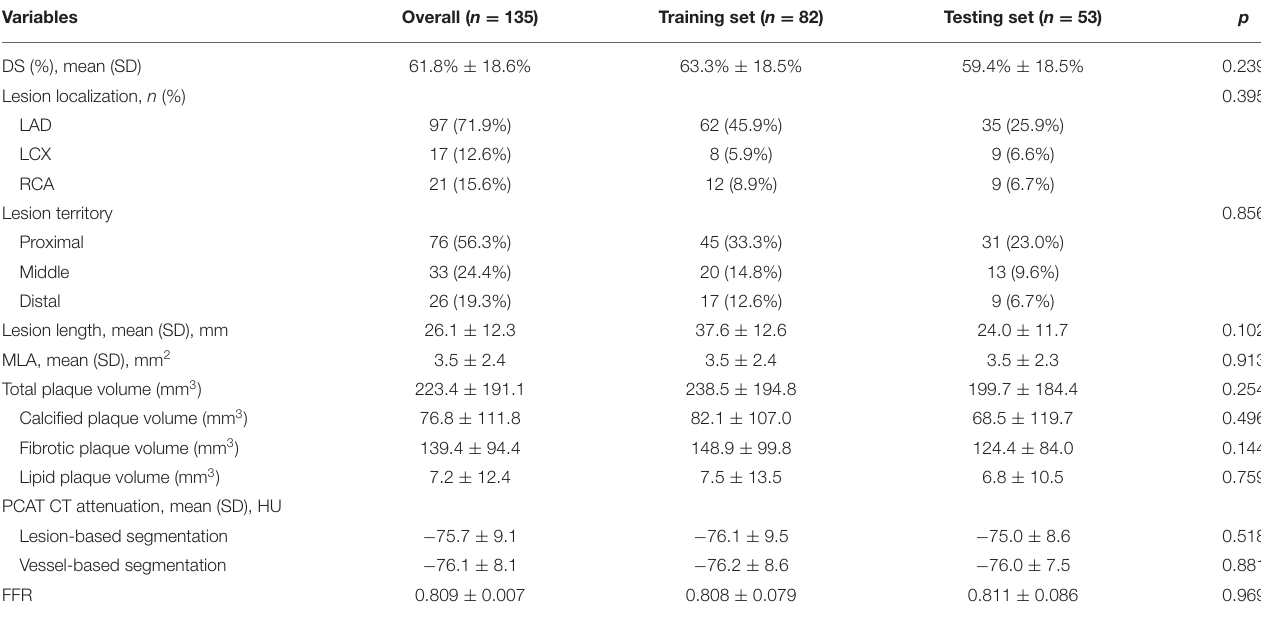
TABLE 3 | Lesion characteristics in the training and testing